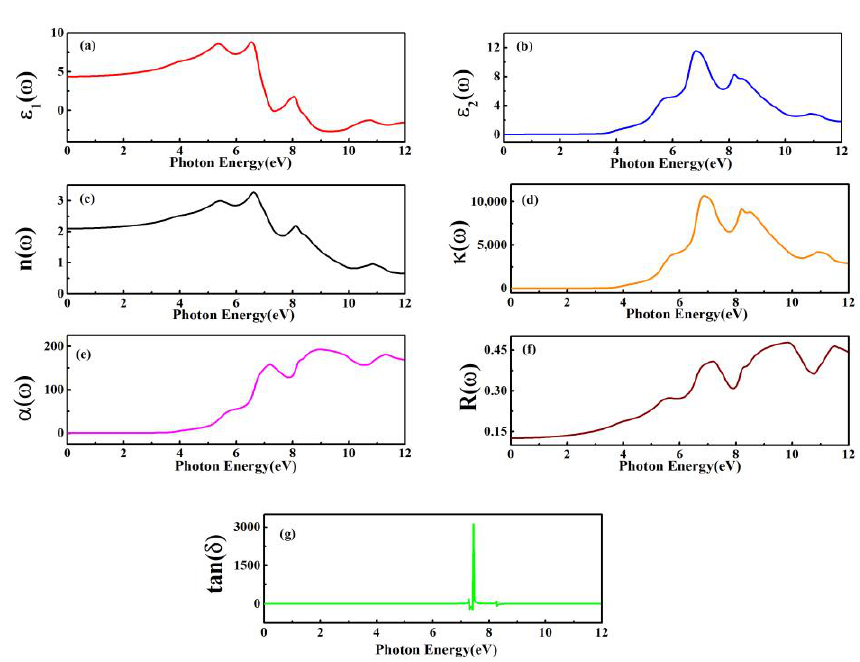
Figure 7. Computed values of ( a ) ε 1( ω ), ( b ) ε 2( ω ), ( c ) n( ω ), ( d ) k( ω ), ( e ) α ( ω ), ( f ) R( ω ), and ( g ) tan ( δ ) for ZnS.